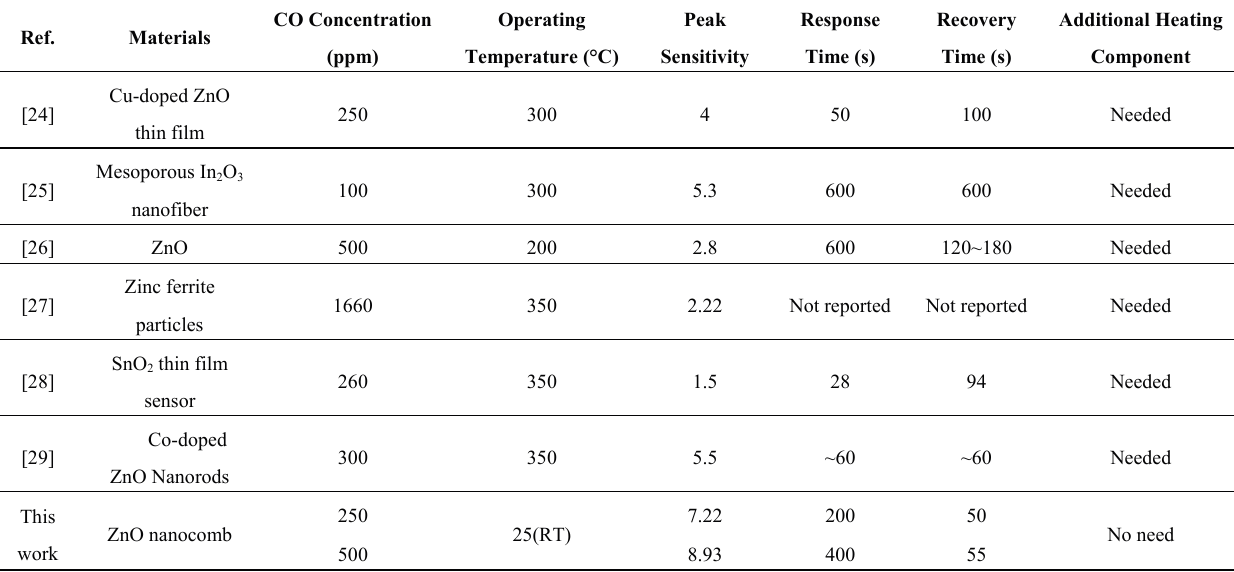
Table 1. Gas sensing performance comparison with previous implementations.